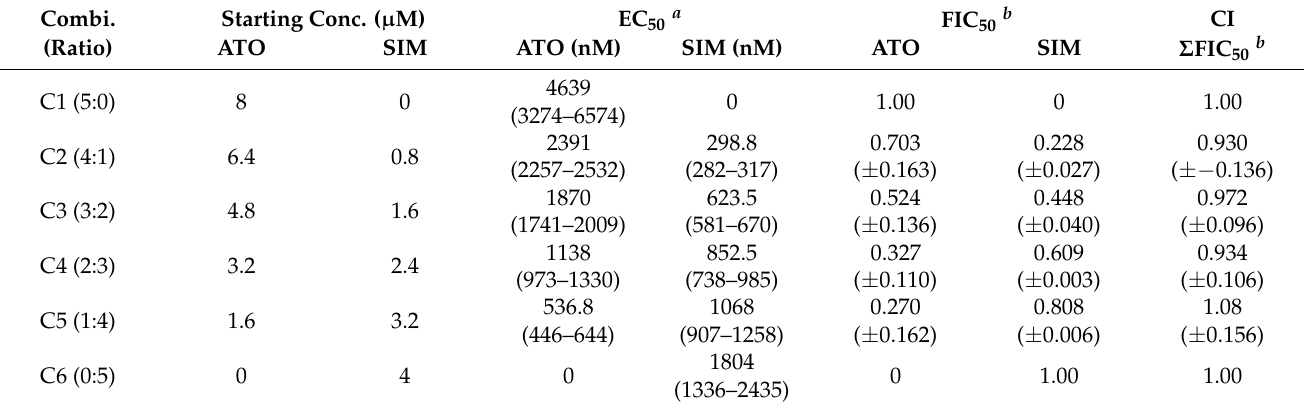
Table 2. Half-maximal inhibitory concentrations of the atorvastatin and simvastatin combinations. Combi.